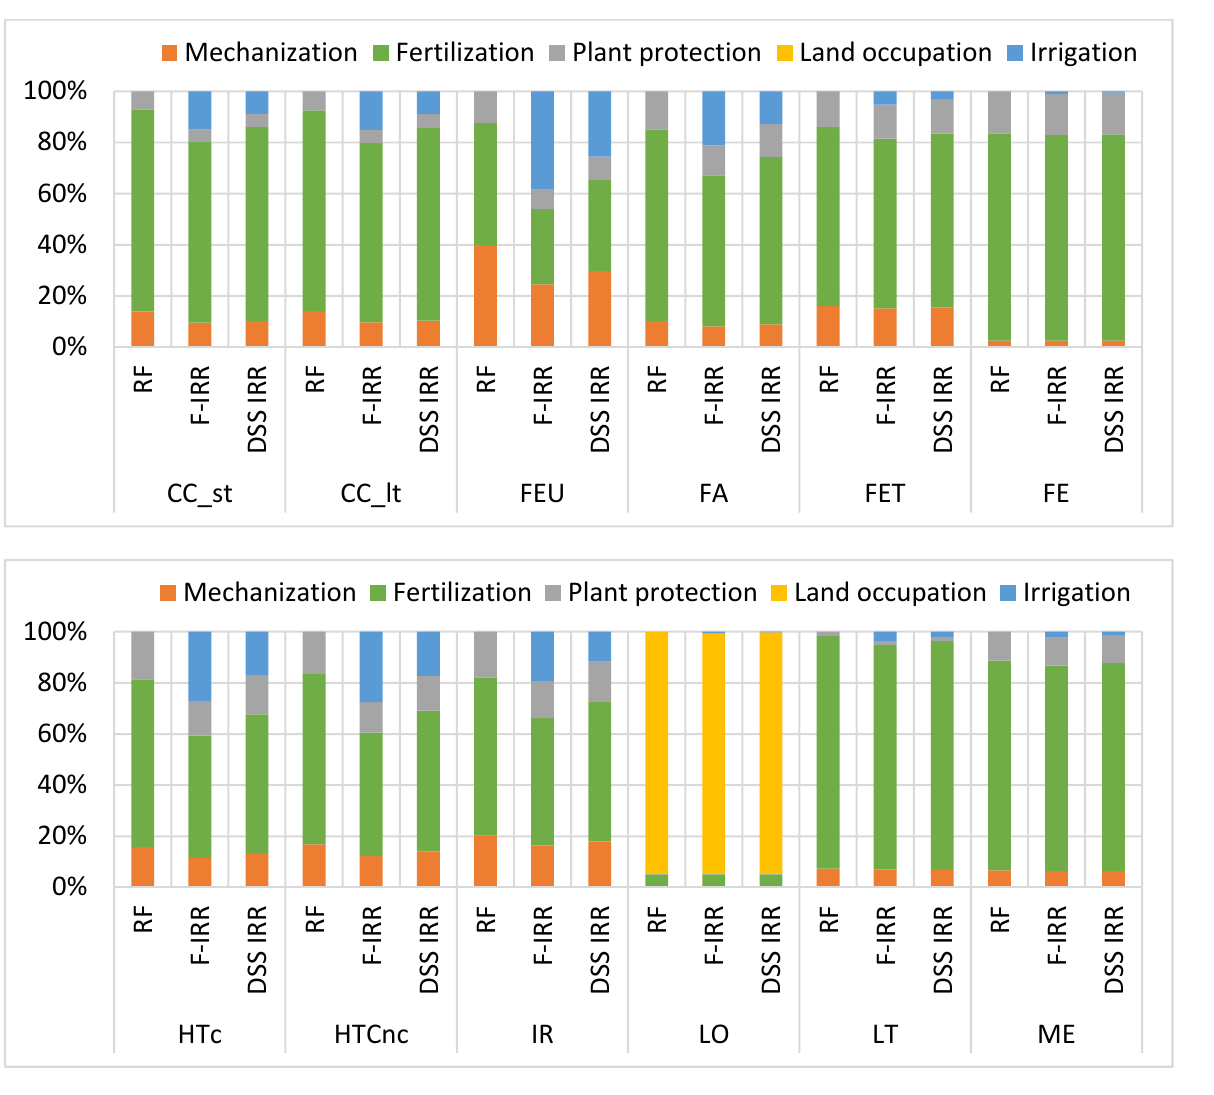
Figure 4. Process contribution analysis on impact categories for rainfed, RF; farmer-led irrigation, F-IRR; DSS-based irri- gation, DSS-IRR. Note: CC = climate change; FEU = fossil energy and nuclear use; FA = freshwater acidification; FET = freshwater ecotoxicity; FE = freshwater eutrophication; HTc = human toxicity cancer; HTnc = human toxicity non cancer; IR = ionizing radiation; LO = land occupation; LT = land transformation; ME = marine eutrophication; MRU = mineral resource use; OD = ozone depletion; PM = particulate matter; POF = photochemical ozone formation; TA = terrestrial acidification; WS = water scarcity. 3.2. Endpoint and Overall Environmental Impact